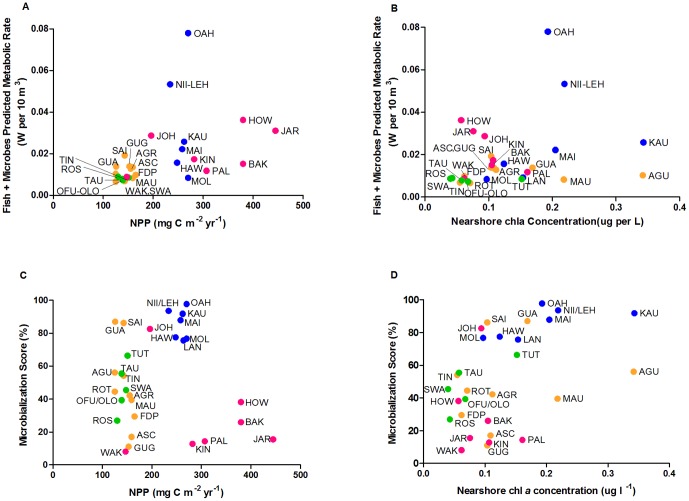
Measures of energy use versus metrics of primary production.(a) Non-linear regression analysis of the combined fish + microbes predicted metabolic rate versus net primary production (NPP) for the 29 surveyed islands. NPP was derived from satellite data using the Vertically Generalized Production Model (VGPM). (y = 0.00008x+0.0012; R2 = 0.21) (b) Non-linear regression analysis of the combined fish + microbes predicted metabolic rate versus nearshore chla concentrations at the 29 surveyed islands (y = 0.54x+0.01; R2 = 0.08) (c) Microbialization scores versus NPP derived from satellite data using the VGPM for the 29 surveyed islands. (d) Microbialization scores versus nearshore chla concentrations at the 29 surveyed islands (y = 171.5x+29.7; R2 = 0.22). Colors are as in Fig. 2. For island abbreviations see Table 1.